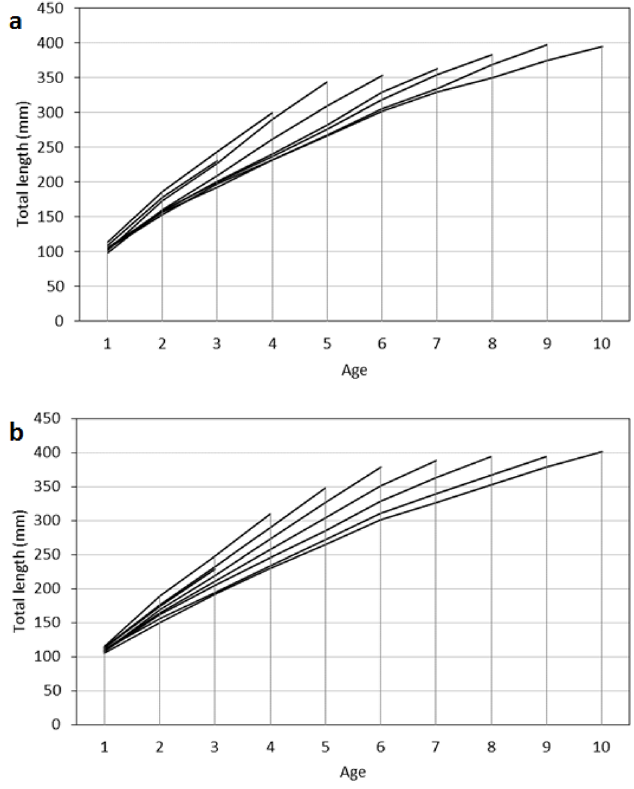
Fig. 5. Mean back-calculated lengths (mm) of pikeperch caught at different ages with trap nets (a) and gillnets